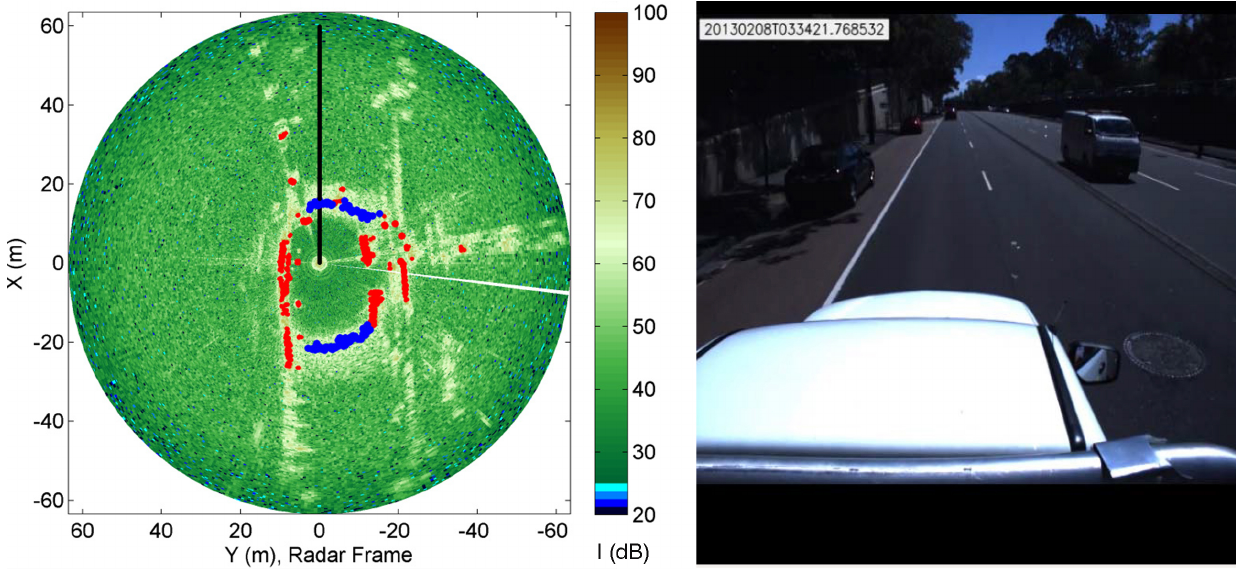
Figure 10. Classification results obtained from the RCGD method overlaid over the radar image ( Left ) in a typical urban environment ( Right ). Blue dot: Radar-labelled ground. Red dot: Radar-labeled obstacle.